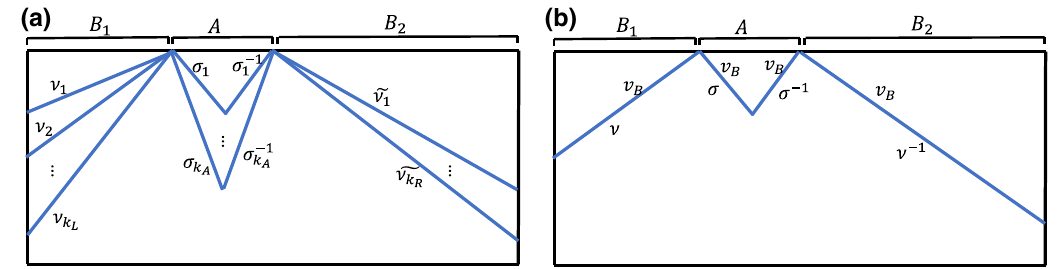
FIG. 21. (a) A general domain-wall configuration that can contribute in the scaling limit and at late times. (b) The leading contribution in the scaling limit for a particular choice of σ , where each of the domain walls has velocity v B